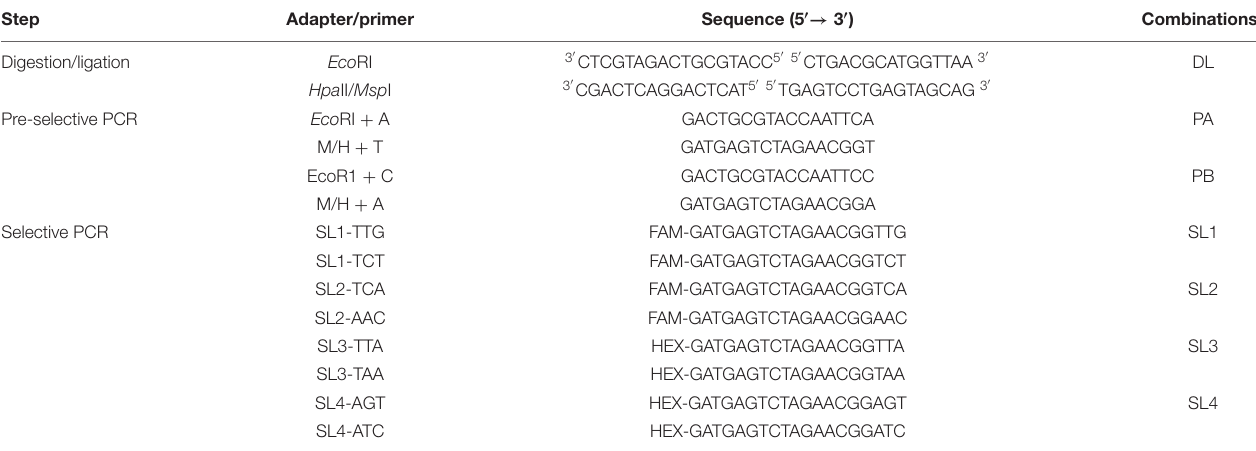
TABLE 1 | Adapters and Primers used for MSAP analysis in A. cervicornis